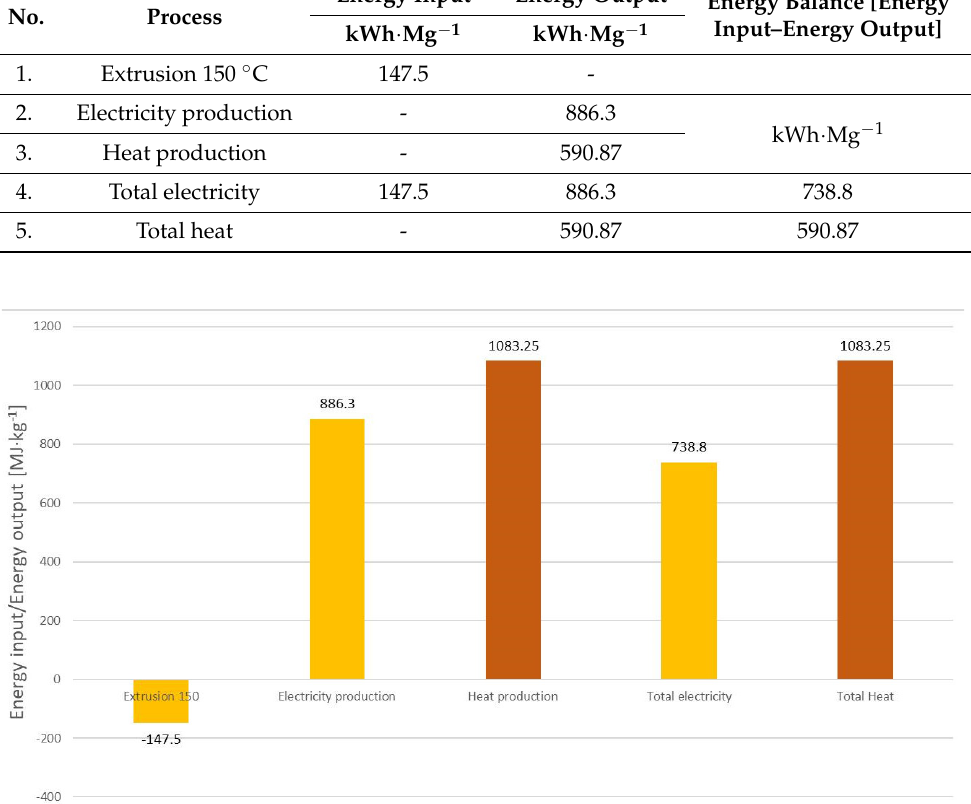
Figure 9. The energy balance of biogas produced from Silphium perfoliatum L. extruded at 150 °C.